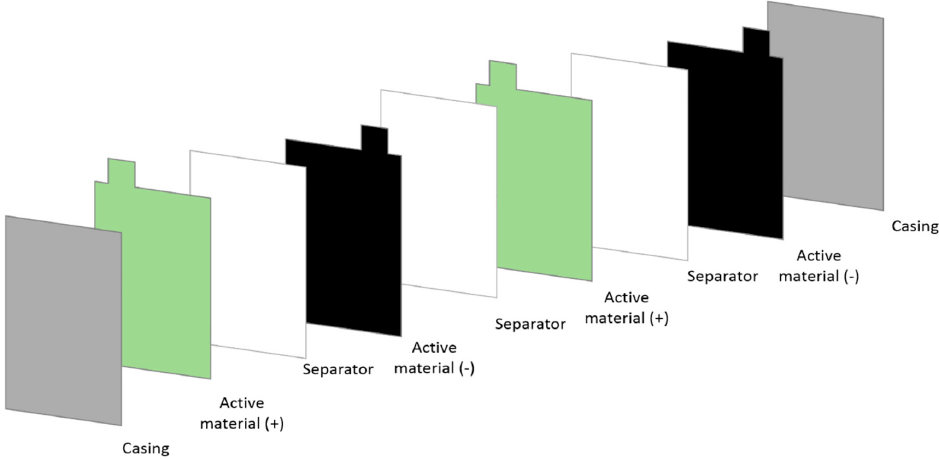
Figure 1. Schematic representation of a pouch cell.